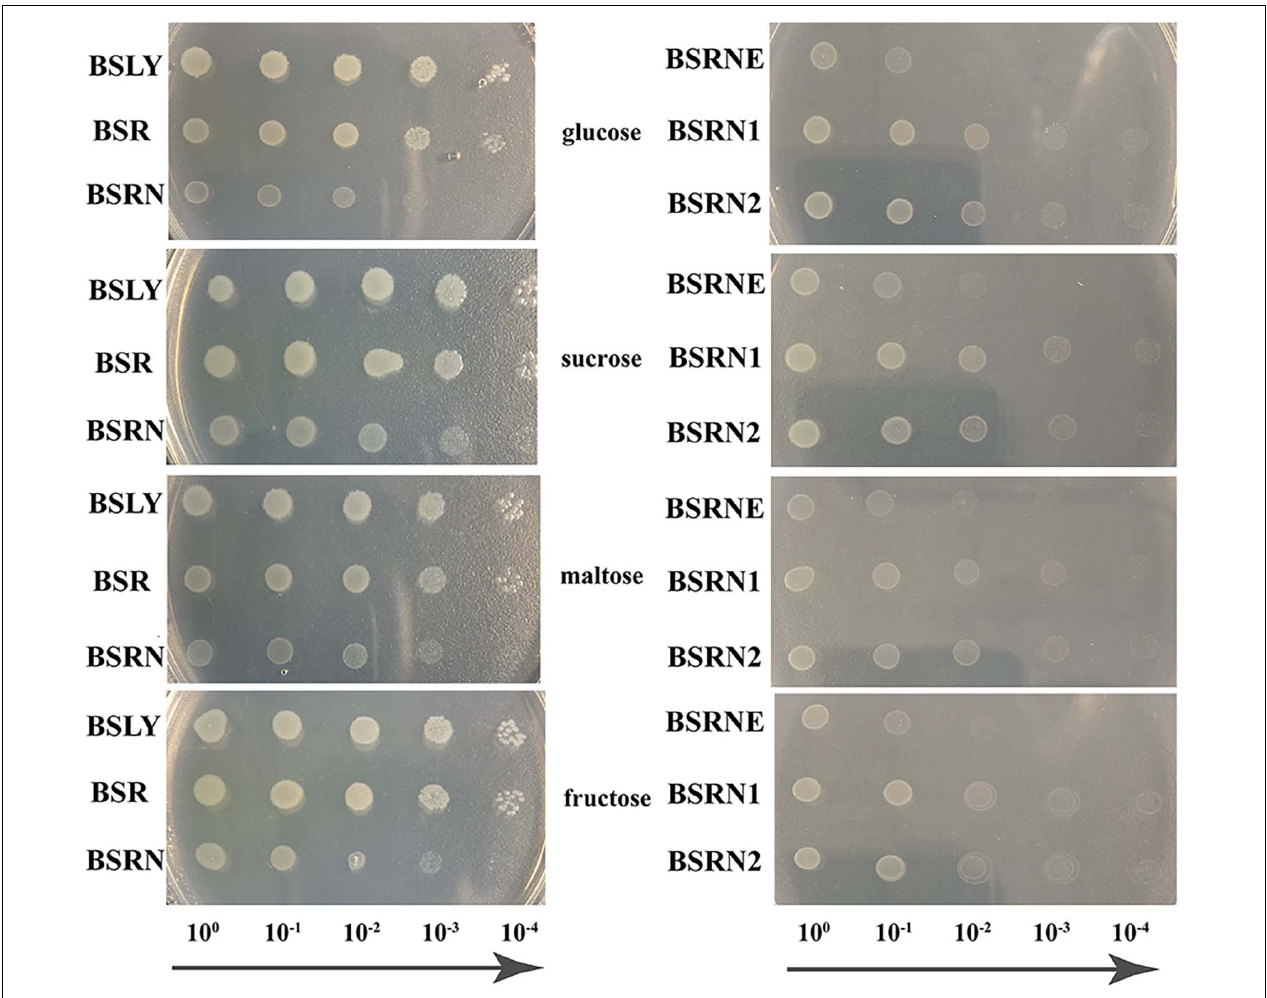
FIGURE 3 | Growth phenotypes of the wild-type and mutant strains grown in GMI media with glucose/sucrose/maltose/fructose as carbon source. (Left) BSLY with wild-type rpe , BSR carrying mutant rpe , BSRN carrying a nonsense mutation of rpe . (Right) BSRNE is a derivative of BSRN harboring the empty vector pHP13(spe), BSRN1 harboring pHP01 carrying the mutant rpe , BSRN2 harboring pHP02 carrying wild-type rpe